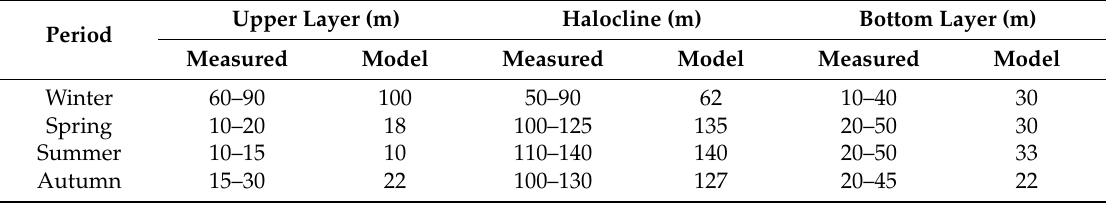
Table 4. Comparison of modeled and measured salinity stratification at station C3 (Sea of Bothnia), 2000. Upper Layer (m) Halocline (m) Bottom Layer (m) Period Measured Model Measured Model Measured Model Winter 60–90 100 50–90 62 10–40 30 Spring 10–20 18 100–125